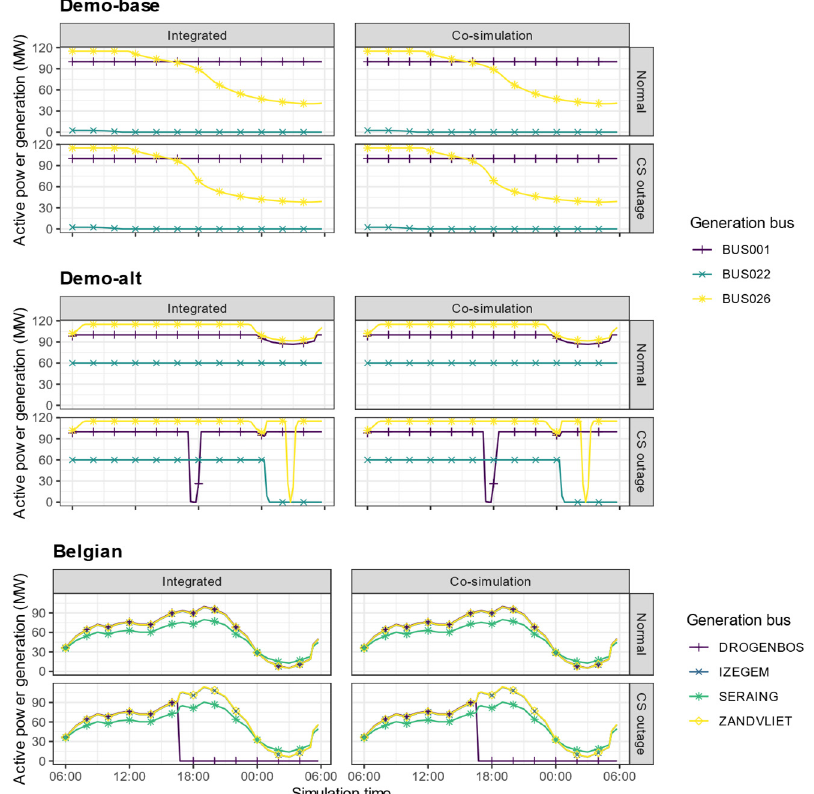
Figure 8. Active power generation (MW) of all coupled generators in each network by scenario. The MAPE across all scenarios is 0%, except for the Demo-alt CS outage scenario, which is identical in all steps except the time period around 18:15, when the generator is responding to the outage (described further in the text).